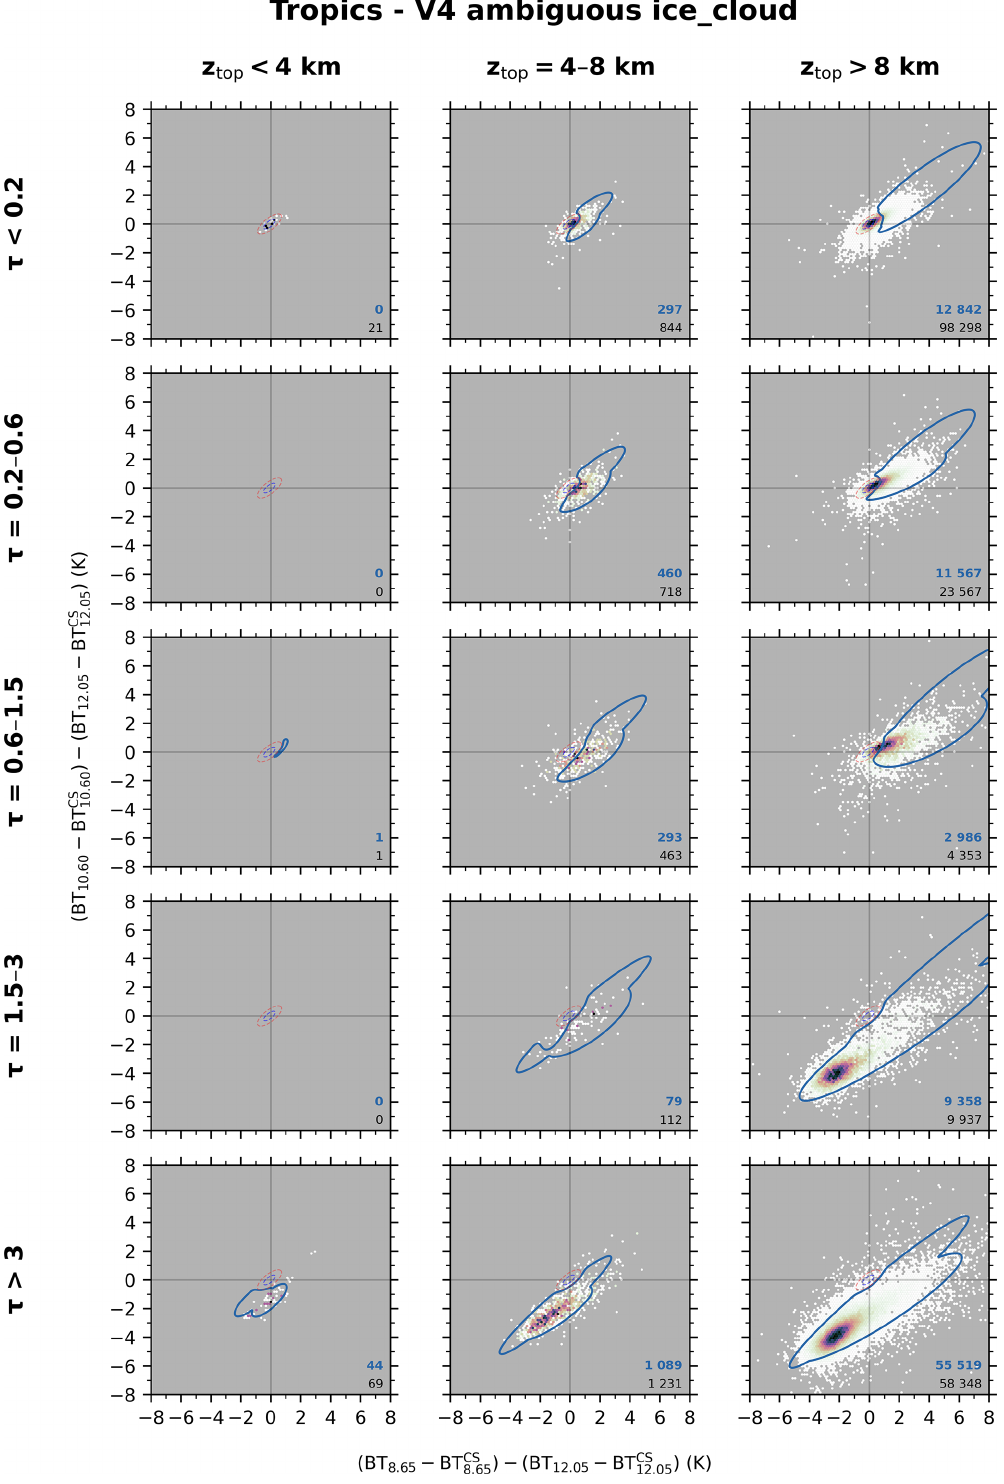
Figure 15. IIR signature of the V4 ambiguous (0 ≤ | CAD score , V4 | < 70) ice cloud observations for the 2008–2019 period in the tropics. IIR signature inside the blue contour ( | CAD score , IIR | ≥ 70) are confidently classified as clouds by the IIR CAD algorithm. At the bottom-right corner of each subplot are indicated the total number of V4 ambiguous ice cloud observations (black) and those that are confidently classified as cloud by IIR